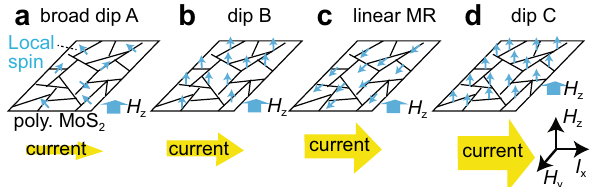
Figure 1. Schematic of the localized spin states in our magnetoresistance measurements. ( a ) In the small current applied, broad MR curves with dips A & A ′ are observed in the H z measurement because of the low spin density with disorder. ( b ) As the current increases, dip B with a large MR ratio is observed because of the high spin density along the H z direction. ( c ) With a greater increase in current, the positive MR disappears, and flat or linear MR is observed because of the current-induced spin–orbit effective magnetic field along the H y direction. ( d ) With a further increase in current, dip C is observed because of the high spin density, in which magnetization is along the H z